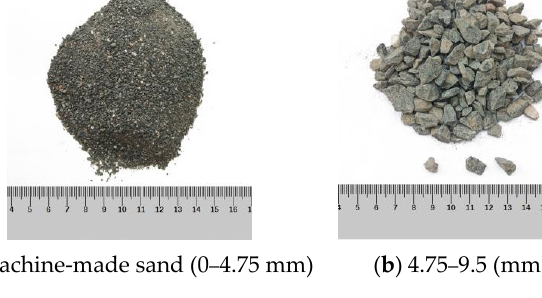
Figure 5. Sampling of crushed stone.